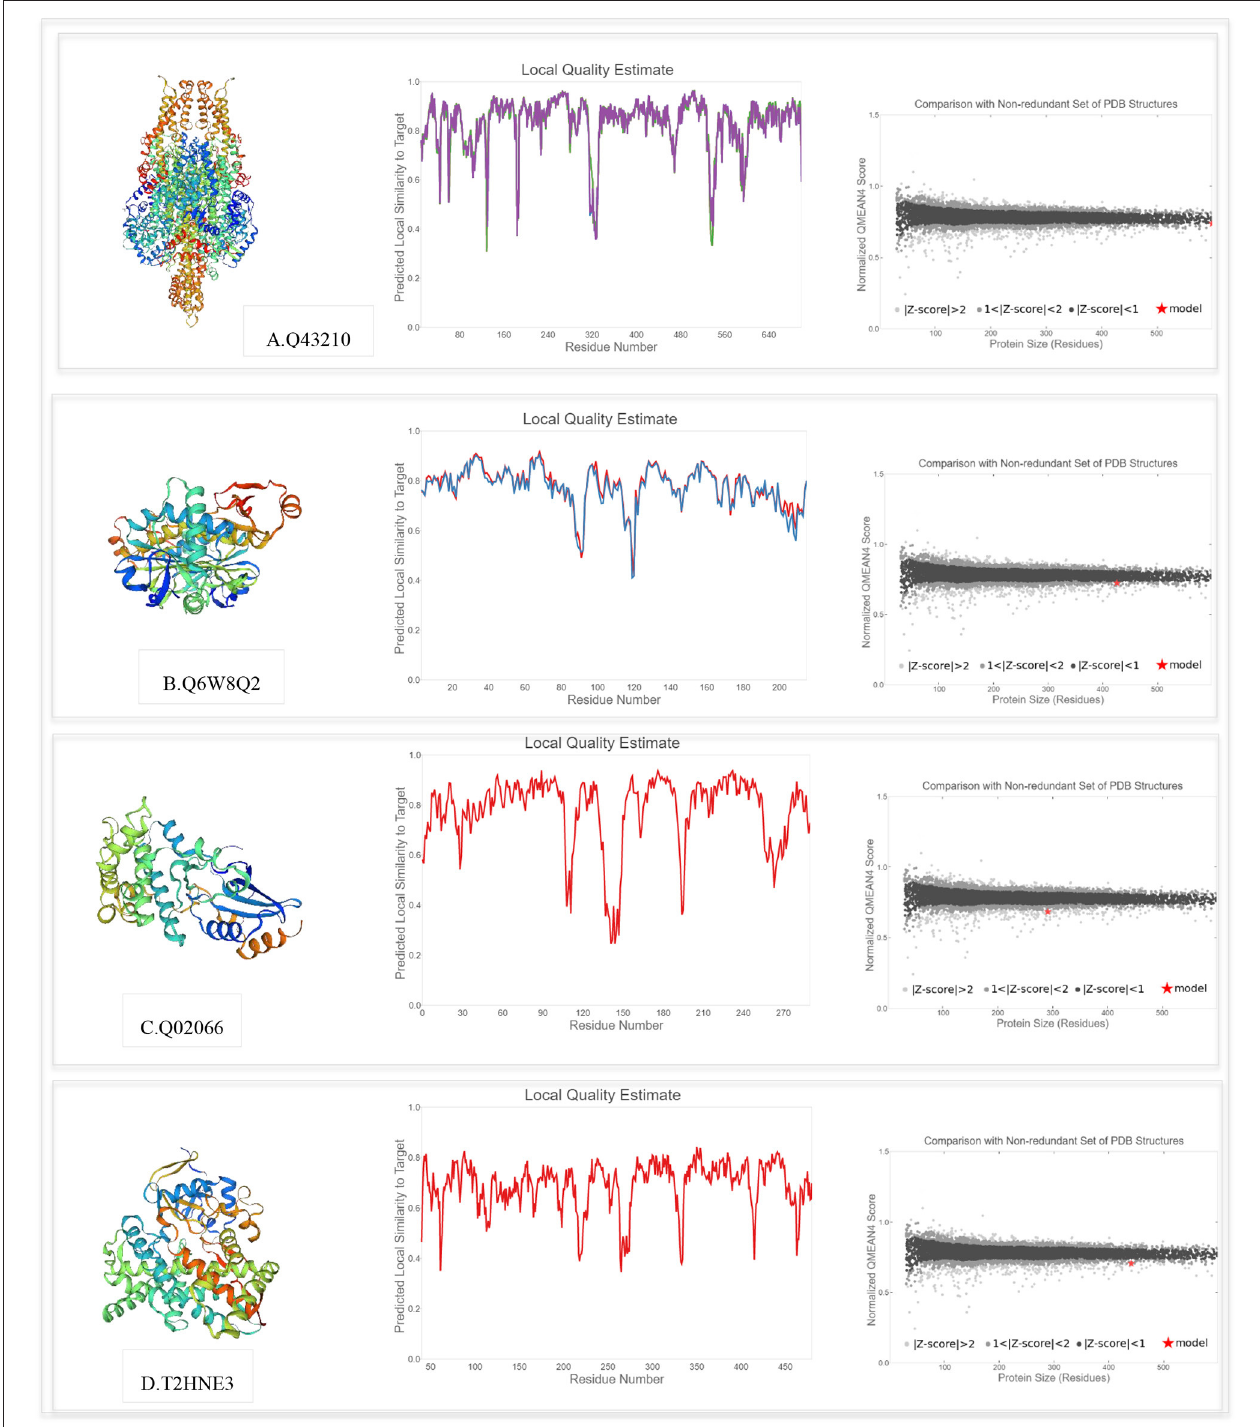
FIGURE 11 | Swiss model 3D structure prediction and model accuracy based on QMEAN for following proteins (according to UniProt ID): (A) Q43210 (Phenylalanine ammonia-lyase), (B) Q6W8Q2 (1-Cys peroxiredoxin PER1), (C) Q02066 (Abscisic acid-inducible protein kinase), and (D) T2HNE3 (ABA 8’-hydroxylase ) . The “Local Quality” plot shows, for each residue of the model (reported on the x-axis), the expected similarity to the native structure (y-axis). In the “Comparison” plot, model quality scores of individual models are related to scores obtained for experimental structures of similar size.